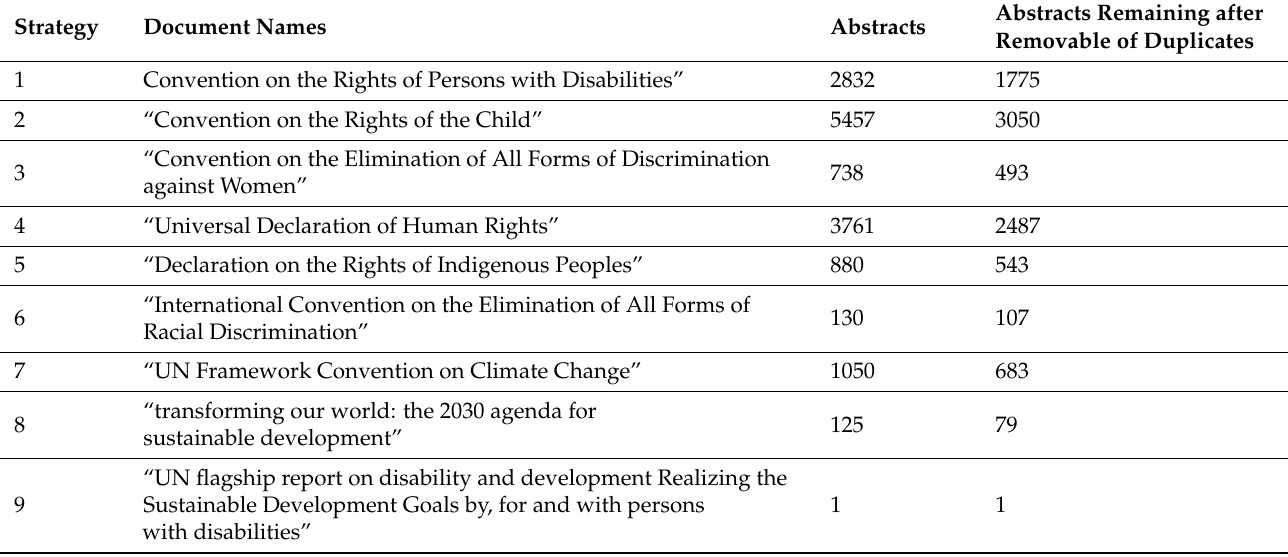
Table 2. Obtaining the abstracts for